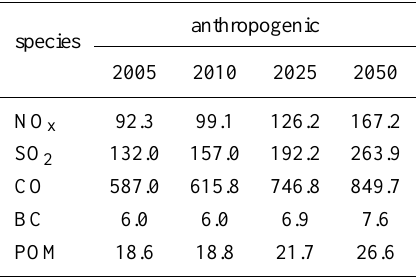
Table 1. Global tracer gases and aerosol emissions used in this work in Tgyr − 1